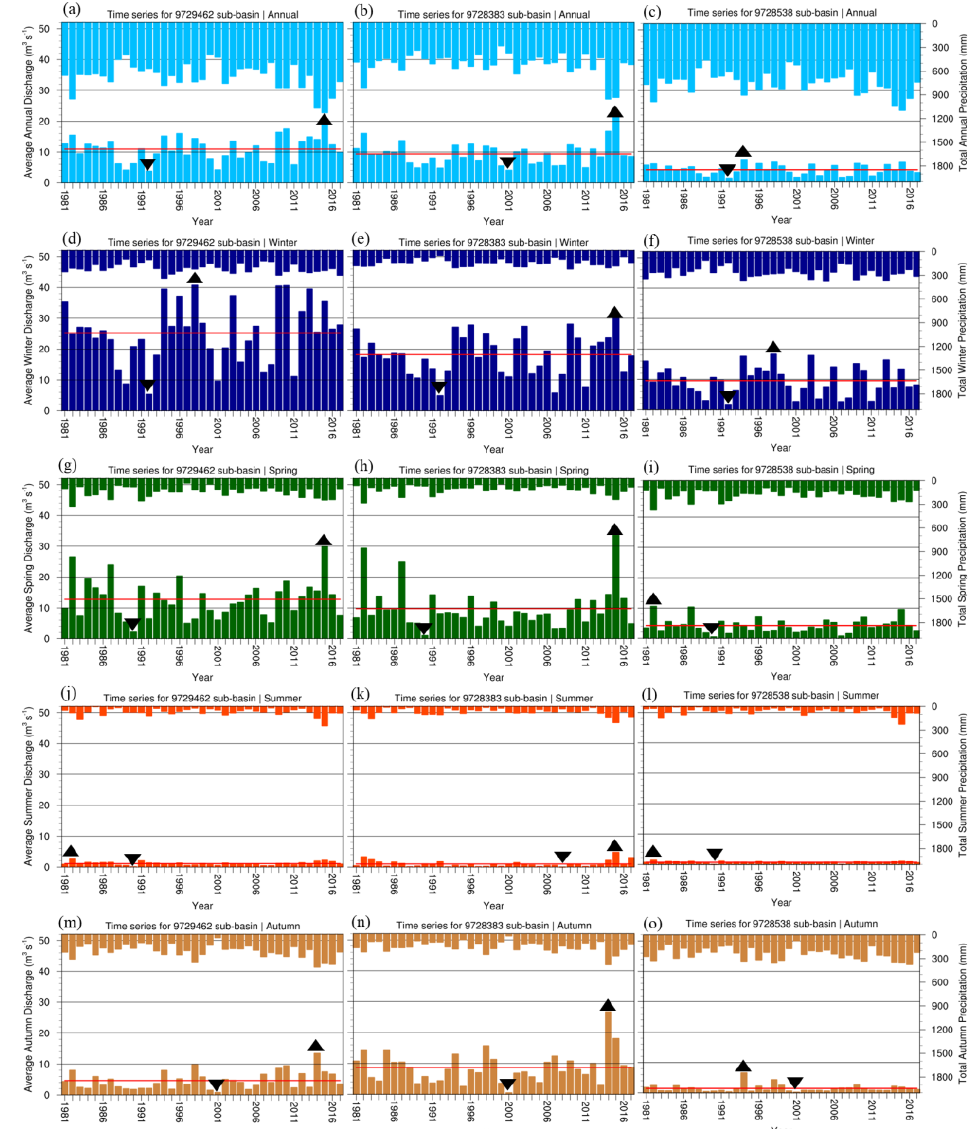
Figure 2. ( a – c ) Time series of average annual discharge (m 3 s −1 ) in the PINUP, TITAR, and MREMA sub-basins from 1981 to 2017; ( d – f ) Similar to ( a – c ) but on a seasonal basis considering winter (December, January, and February—DJF); ( g – i ) Similarly for spring (March, April and May—MAM), ( j – l ) for summer (June, July, and August—JJA) and ( m – o ) for autumn (September, October, and November—SON). Triangles and inverted triangles depict maxima and minima, respectively, while red lines represent 37-year averages. Total annual and seasonal precipitation (mm) is also depicted for the three sub-basins, respectively, using the inverted y-axes on the right.